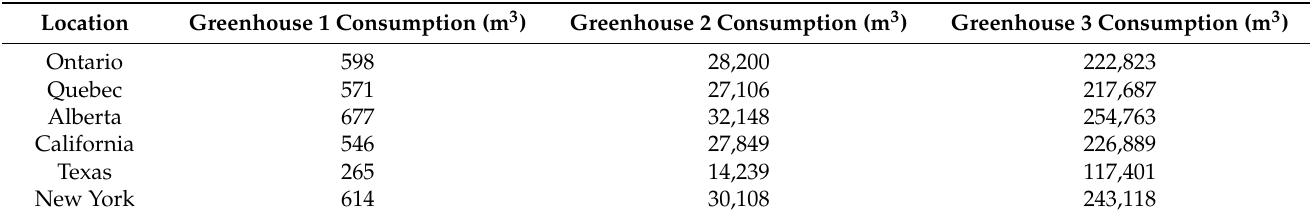
Table 5. Annual Natural Gas consumption (m3) for greenhouse heating in six North American